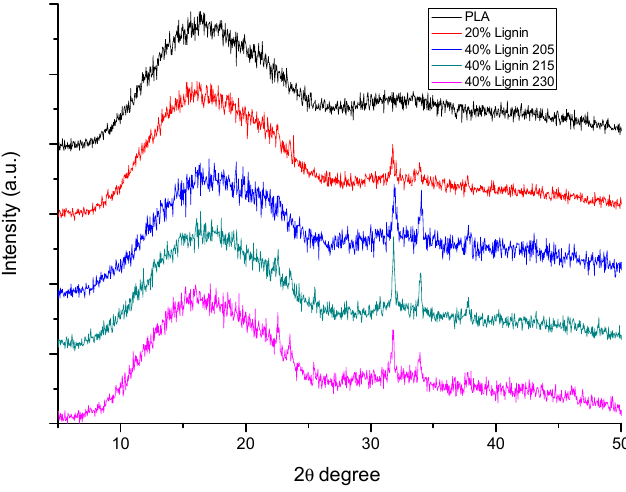
Figure 7. X-ray diffraction analysis (XRD) patterns of PLA and PLA/Lignin biocomposites .